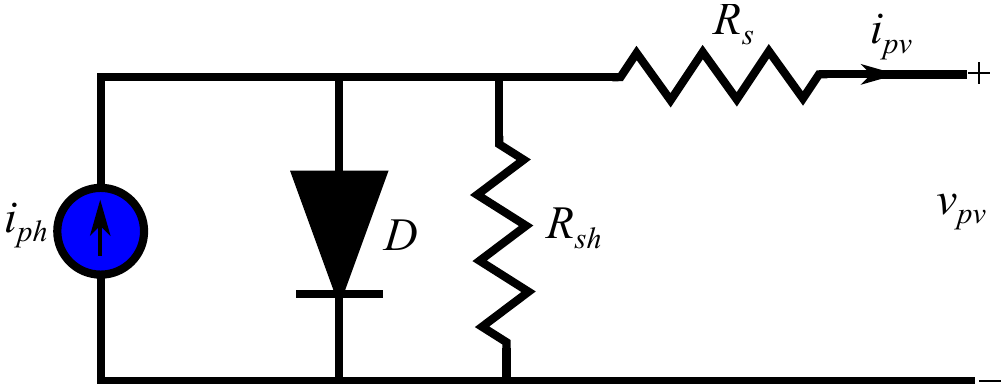
Figure 1. Equivalent circuit of the PV module.